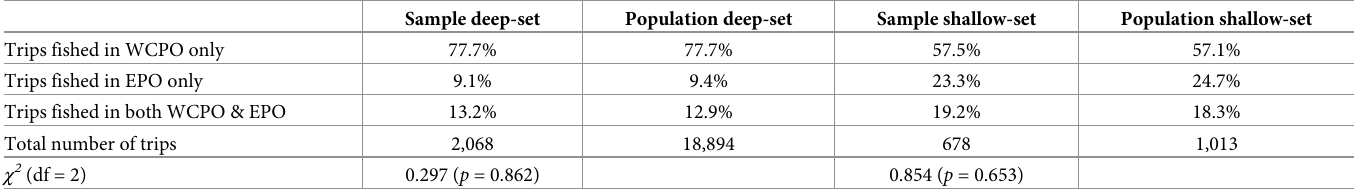
Table 3. Distribution of trips by fishing area, and chi-square results for trips by fishing area with sample and population proportion, for deep-set and shallow-set trips.